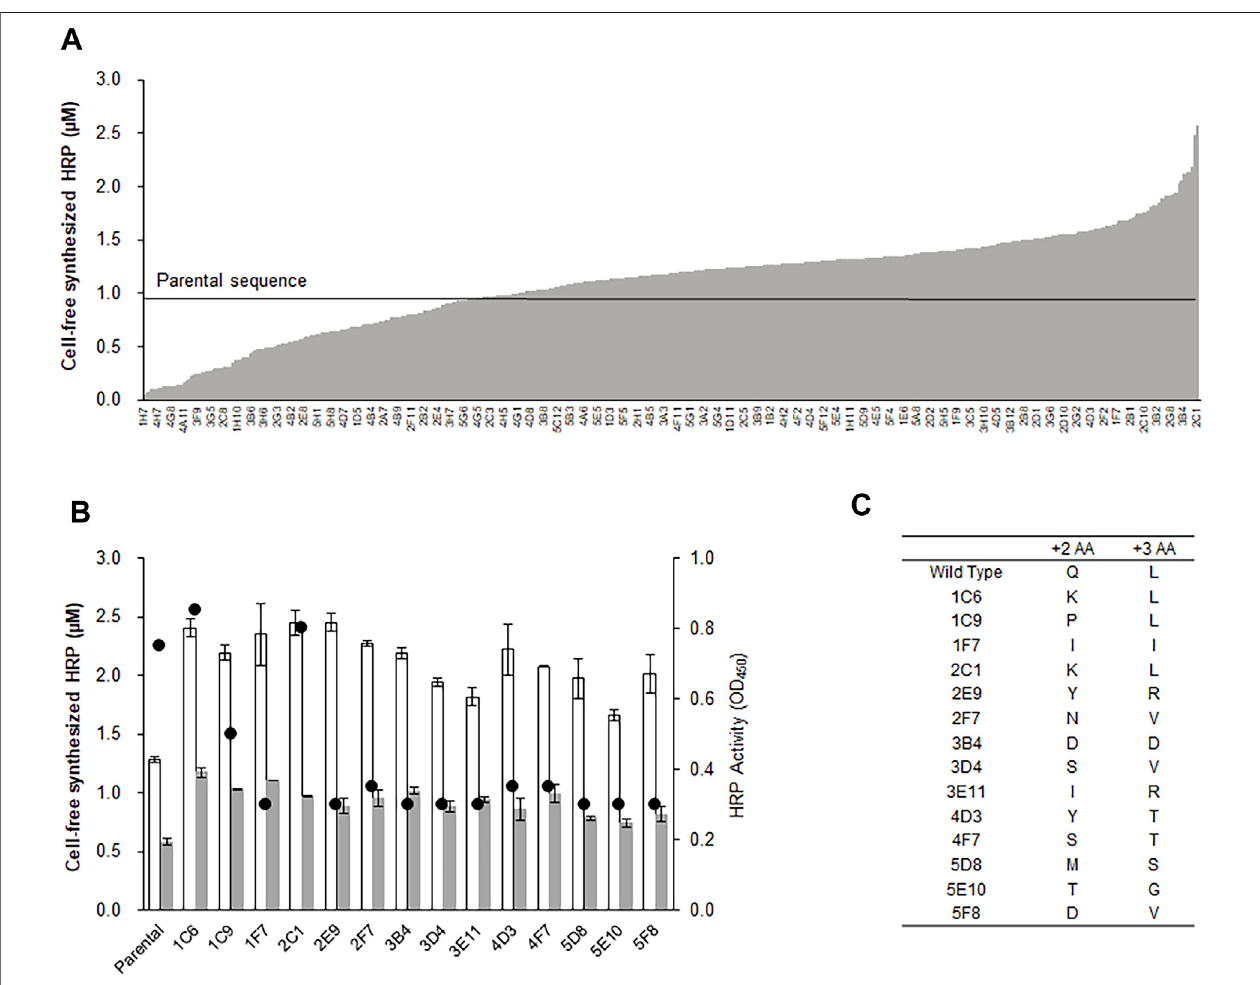
FIGURE2| Randomization and selection ofinitial codons for enhanced production ofHRP. The+2 and +3codons ofthehrp genewasrandomized byPCRusing degenerate primers. After transforming E. coli cells with the library of the plasmids containing randomized genes, each of the variant genes were ampli fi ed by colony- PCR,and expressed intheoptimized reaction mixture forcell-freeprotein synthesis. (A) Resulting yieldsofHRPsynthesisfromtheindividualvariant genes.Thelabelsof X-axisindicatethelocationsofvariantclonesin96wellplates. (B) Totalyields(blankbars),solubleyields( fi lledbars),andenzymeactivity(circles)ofselectedclones. Measurements were performed in triplicate, and the error bars represent the standard deviations of three independent experiments. (C) Amino acid residues at the +2 and +3 codons of the variant clones.